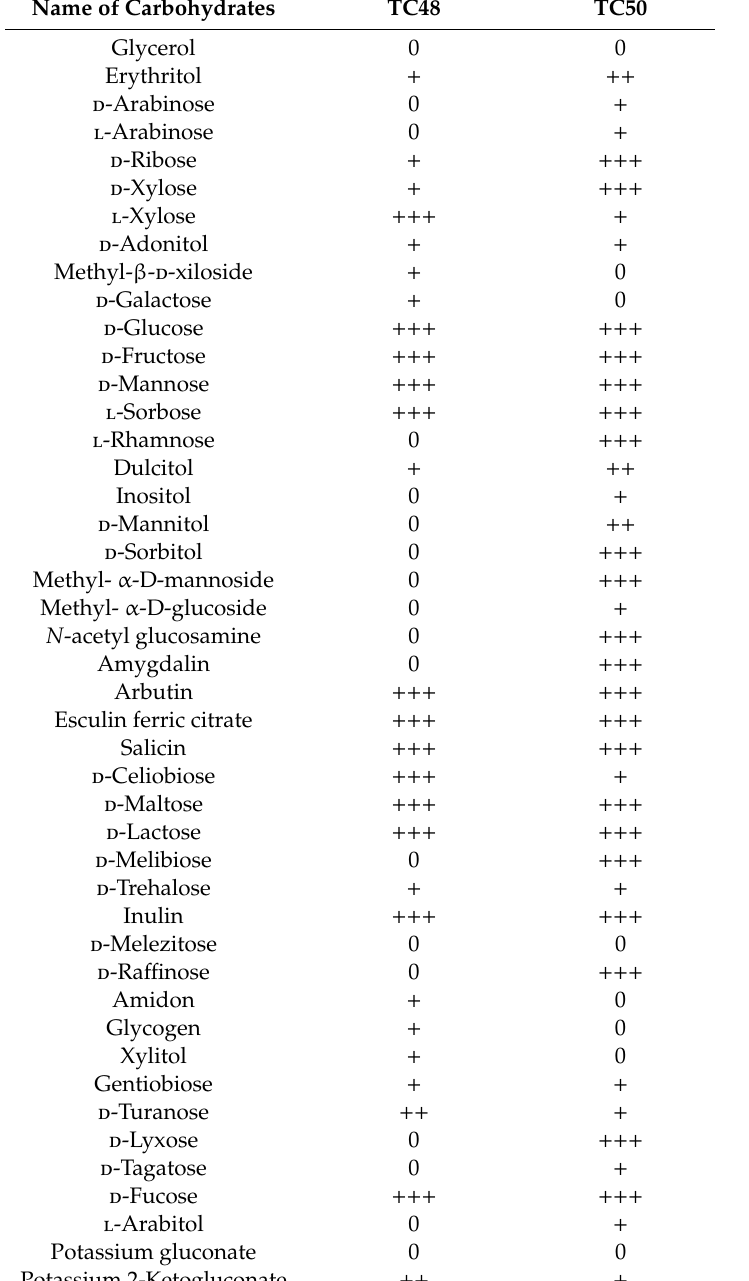
Table 3. TC48 and TC50 ferment di ff erent carbohydrate substrates—in